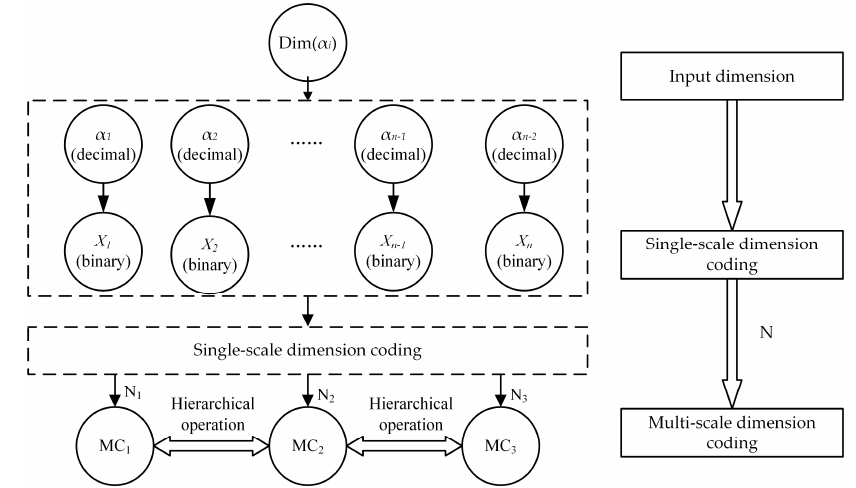
Figure 3. The principle of multi-scale dimension integer coding.